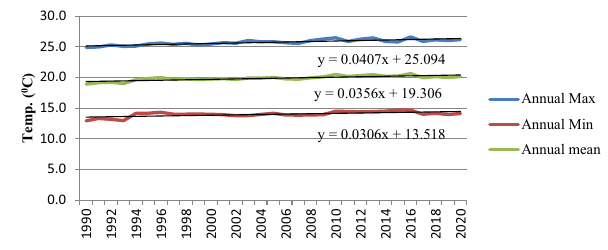
Fig. 7 Annual max, min and mean temperature trend of the water- shed